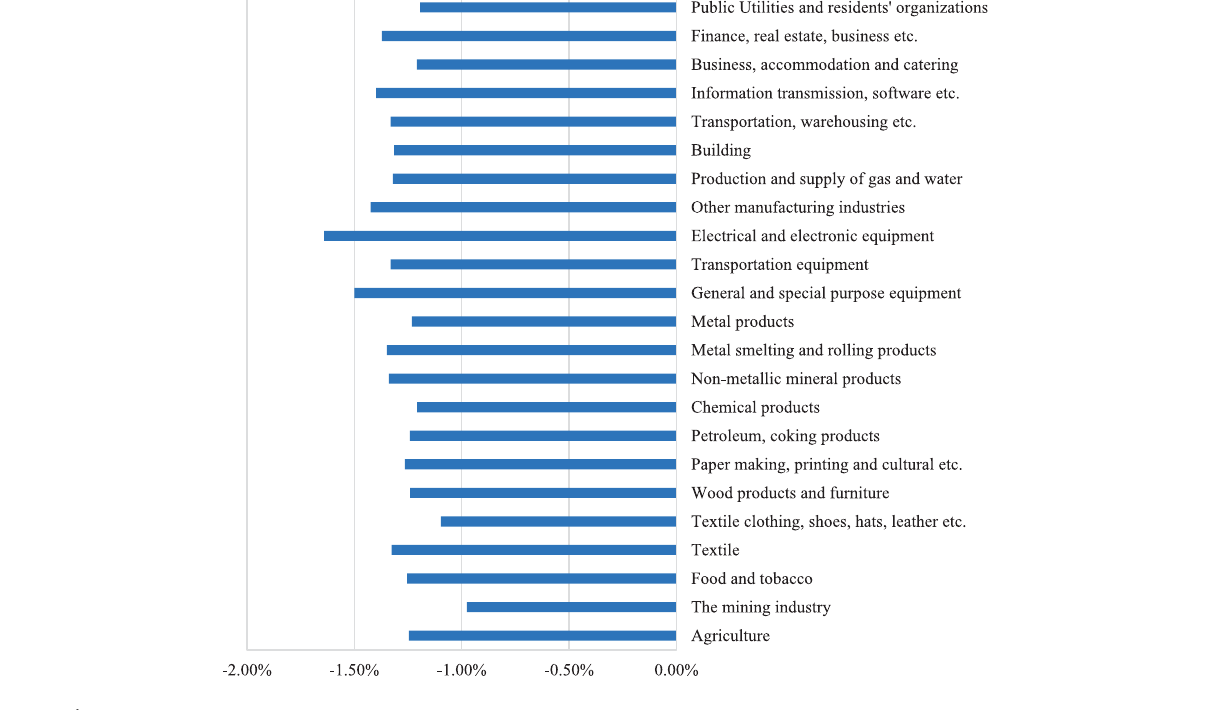
FIGURE 5 | Changes in electricity consumption by